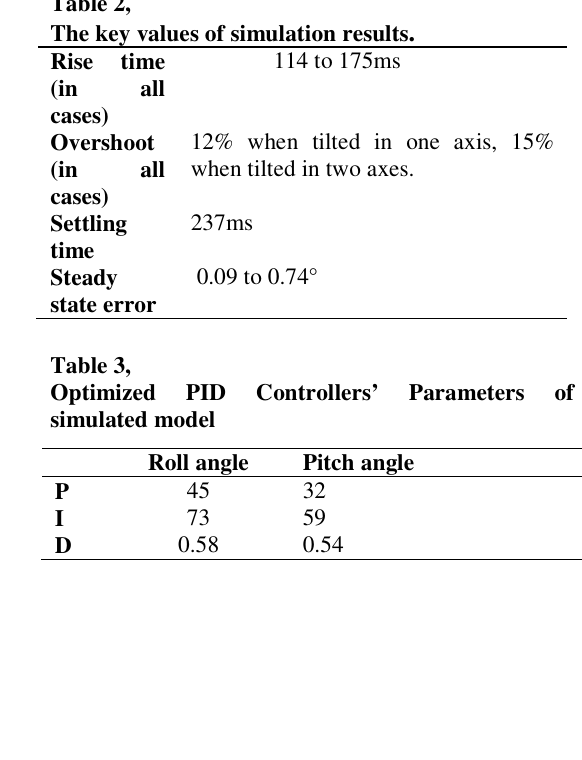
Genetic Algorithm parameters . S.No. GA Parameters Value/ Method Optimization tool Matlab Genetic Algorithm Toolbox